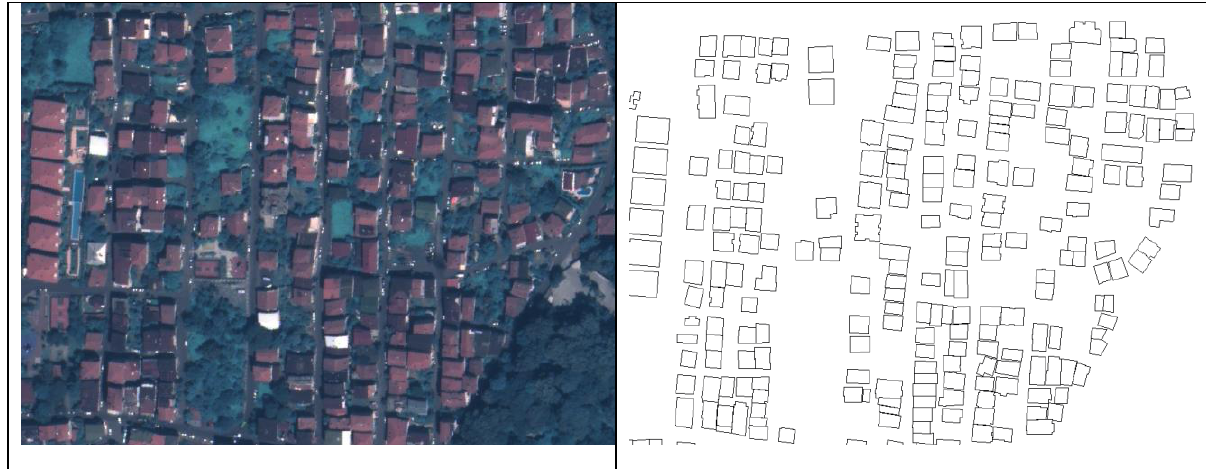
Figure 11. Object comparing with Worldview-4(left) image and 1/5000 scale Topographic map (right) in the area of the